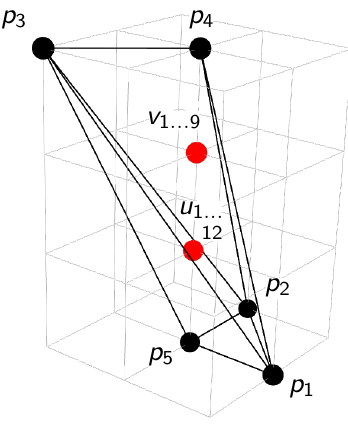
Figure 19 . Toric diagram of Y 3 , 3 ( CP 2 ) .